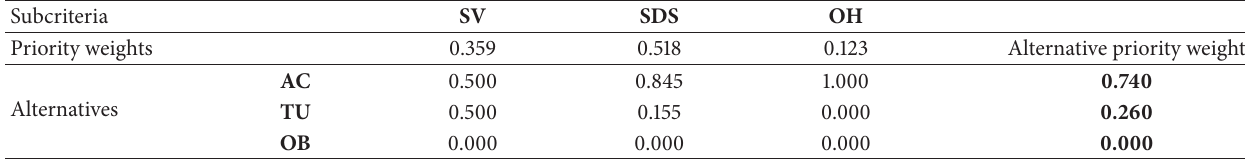
Table 9: Summary combination of priority weights: subcriteria of service